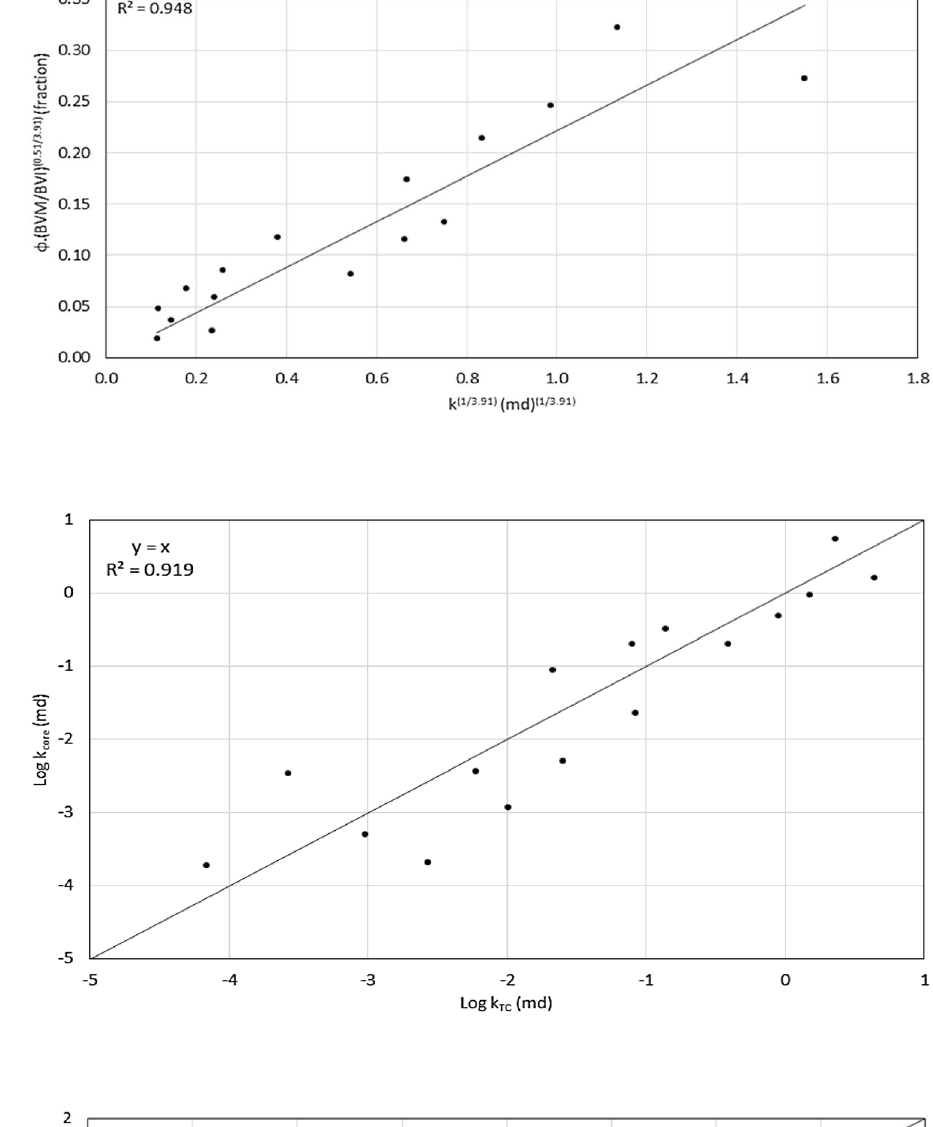
Fig. 12 Correlation of core per- meability and permeability of modified TC model (test model, m = 3.91, n =